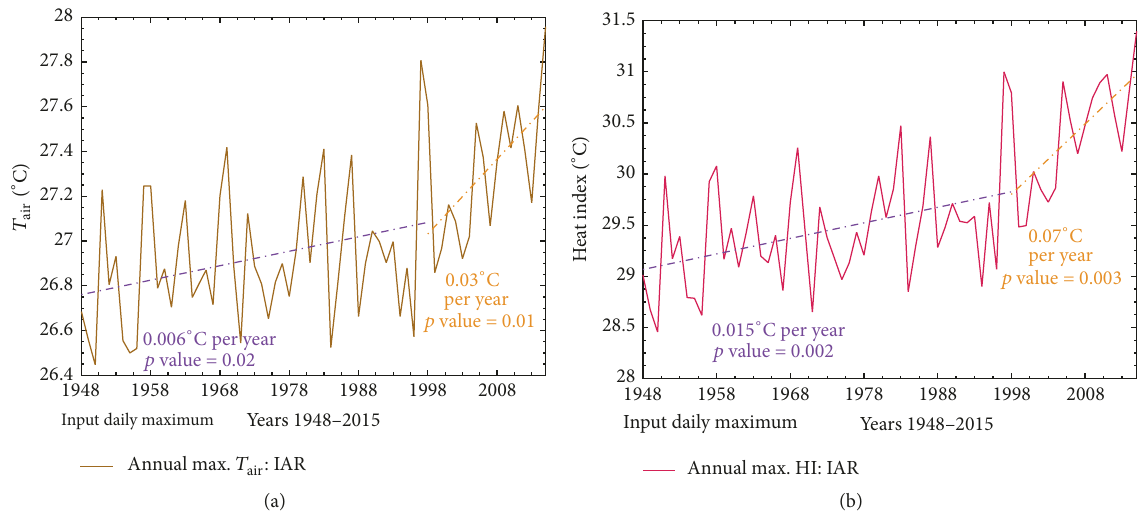
Figure 3: Climate disruption acceleration since 1998 on the IAR using (a) the maximum annual temperature and (b) the maximum annual heat